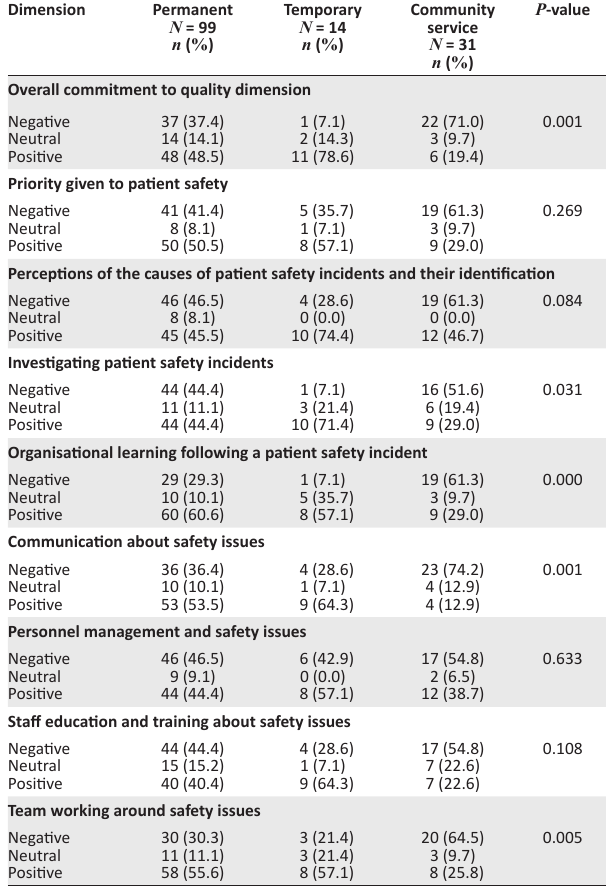
TABLE 3: Analysis of the nine quality dimensions and professional profile. Dimension